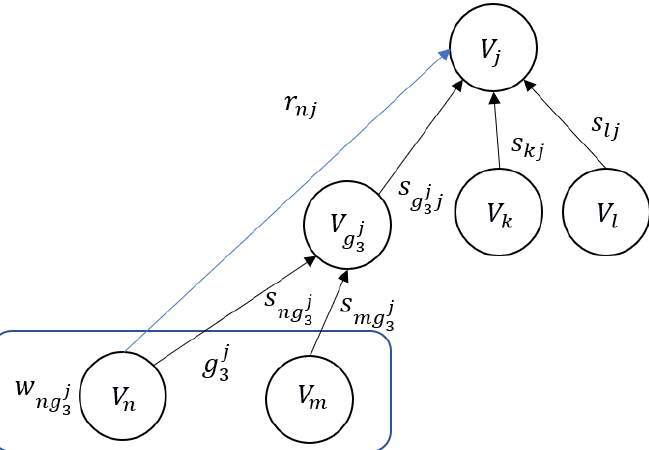
Figure 3. The principle of calculating the criticality of redundant